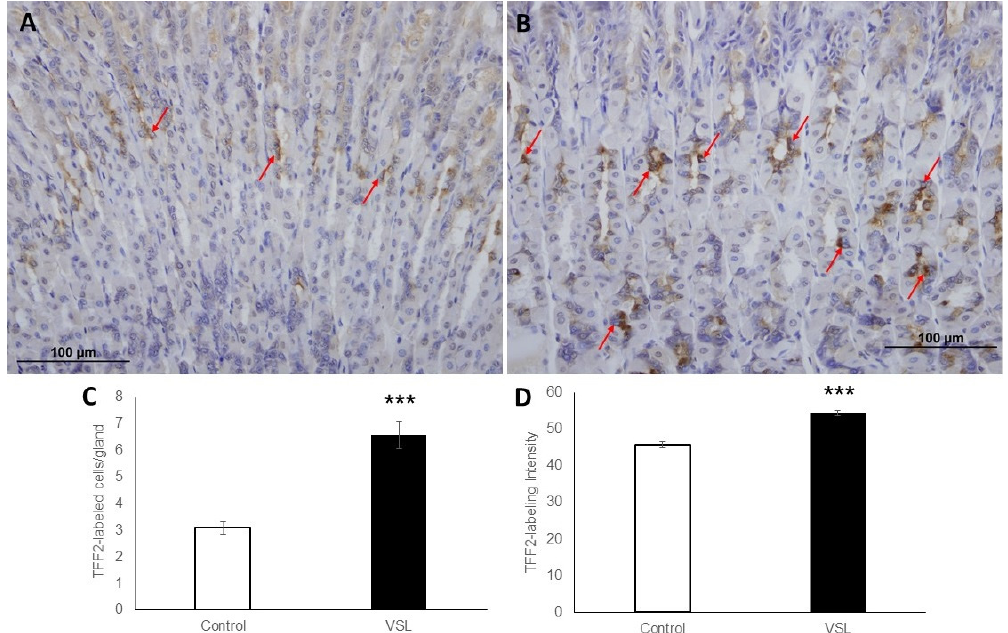
Figure 5. Immunohistochemical analysis of TFF2-labeled epithelial cells in tissue sections obtained from the gastric mucosa of control ( A ) and VSL-treated ( B ) mice. Magnification bar = 100 µm. Analysis of TFF2-labeled cell counts per gland in the gastric corpus of control and VSL-treated mice ( C ), and TFF2-labeling intensity per field in the oxyntic glands of control and VSL treated mice( D ). Data from four control and four VSL-mice are presented as mean ± SE. The asterisks indicate significant differences from the control group. *** p < 0.001.